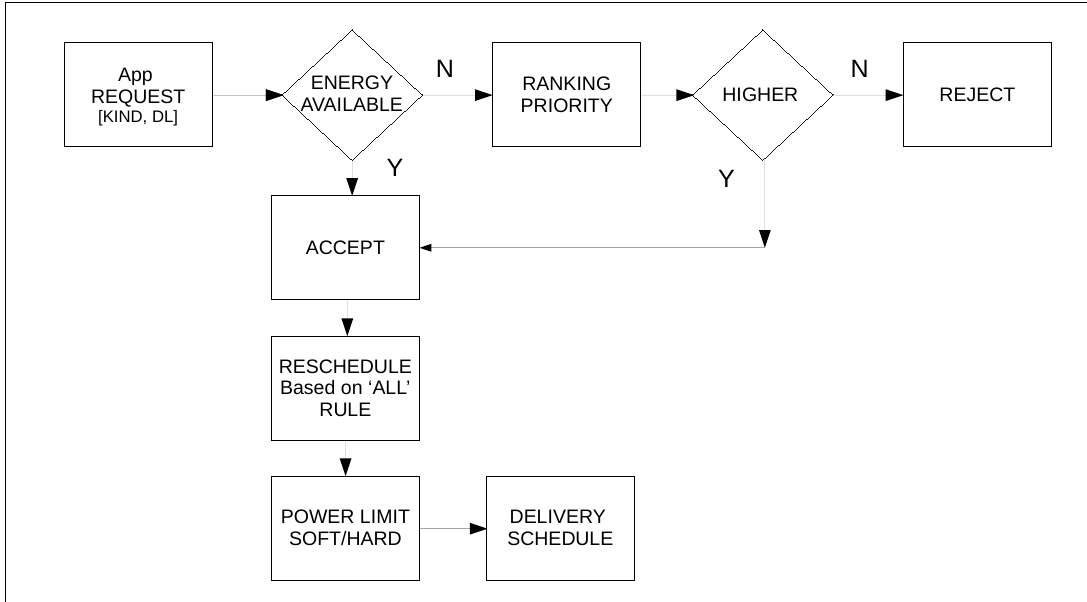
Figure 2. Flowchart of the proposed packetized energy